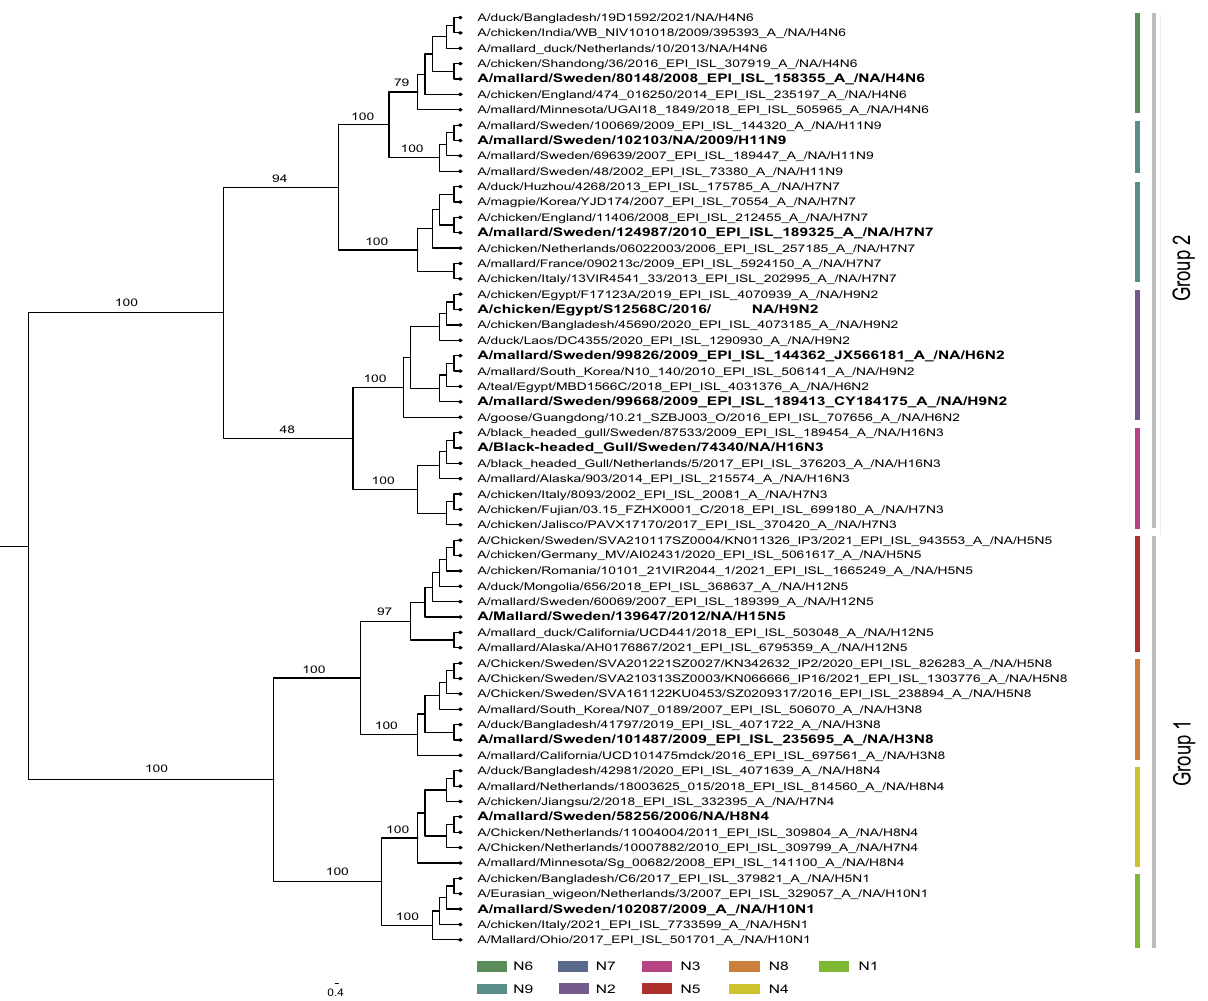
Figure 1. HYPERLINK "sps:id::fig1||locator::gr1||MediaObject::0" RAxML midpoint tree based on wild bird and poultry-adapted Neuraminidase sequences (N1–N9). The scale bar represents nucleotide substitutions per site, and branch labels show the bootstrap value in percentage. Virus isolates used in this study are highlighted in